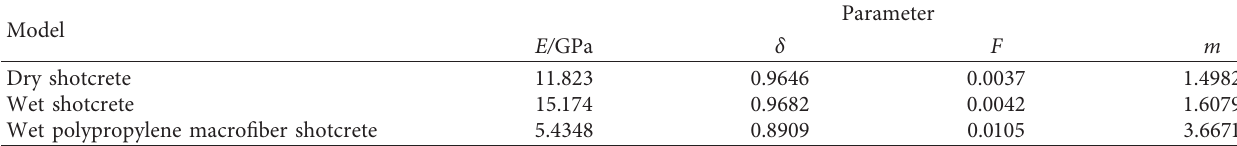
Table 5: Parameters pertaining to the statistical damage constitutive model.